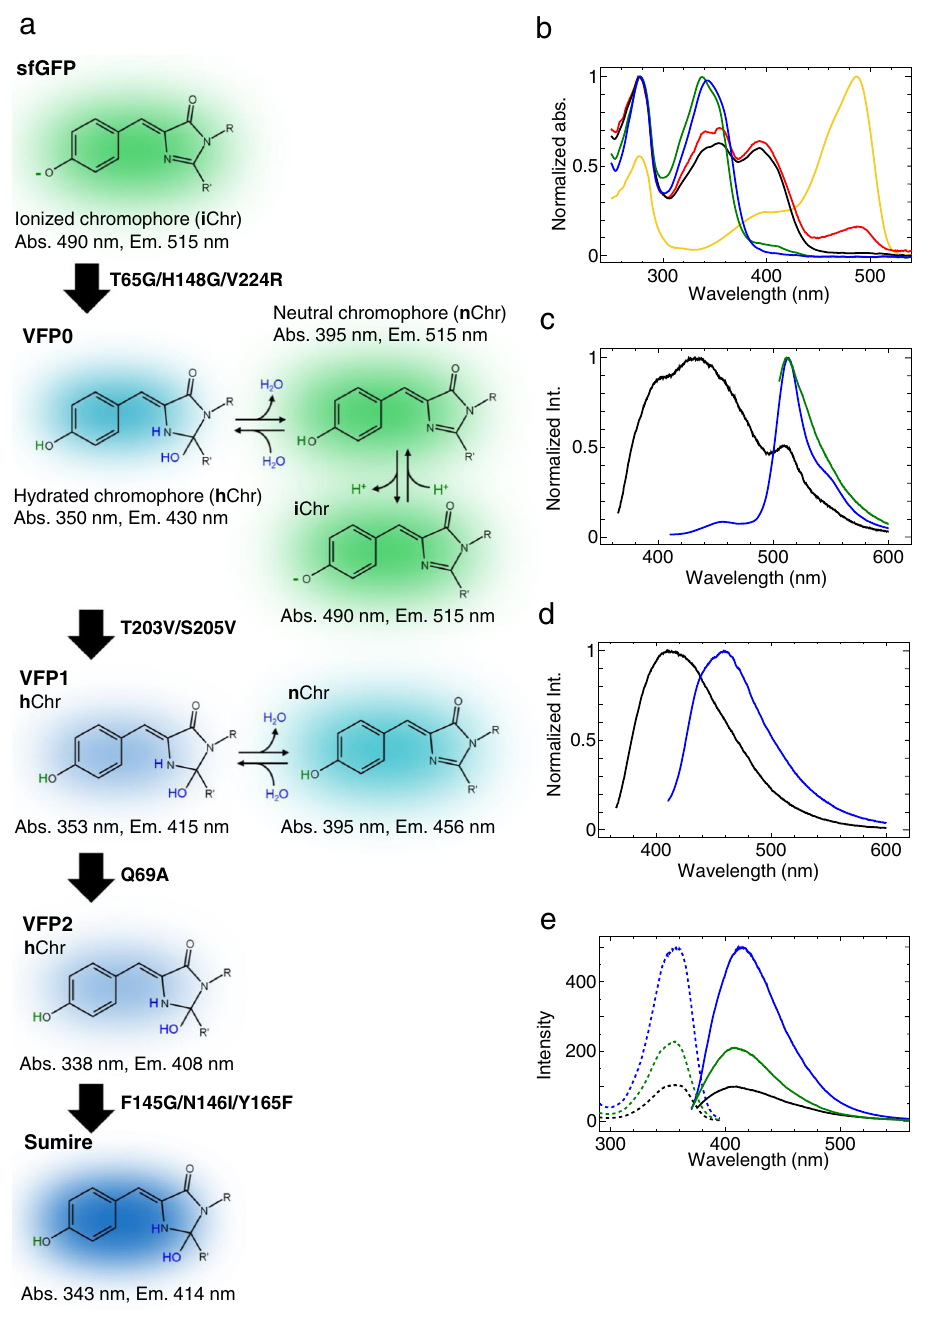
Fig. 1 Designs and spectral properties of VFPs. a Schematic diagram of expected chromophore states of Sumire and parent proteins. b Normalized absorption spectrum of sfGFP (yellow), VFP0 (red), VFP1 (black), VFP2 (green), and Sumire (blue). c Normalized emission spectra of VFP0 excited by 350 nm (black), 395 nm (blue), and 490 nm (green). d Normalized emission spectra of VFP1 excited by 350 nm (black) and 395 nm (blue). e Excitation (dash line) and emission (solid line) spectra of VFP1 (black), VFP2 (green), and Sumire (blue). Spectra data are average measurements of independently prepared samples ( n =